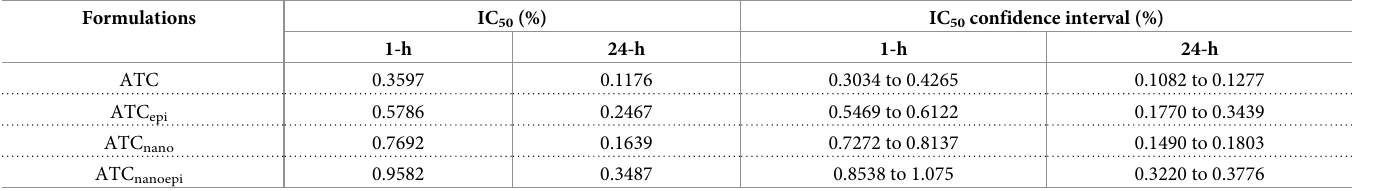
Table 2. Half-maximal inhibitory concentration (IC 50 : Concentration for inhibition of 50% of the cells) and confidence interval (%) after 1-h and 24-h exposure of HaCaT cells to articaine formulations.